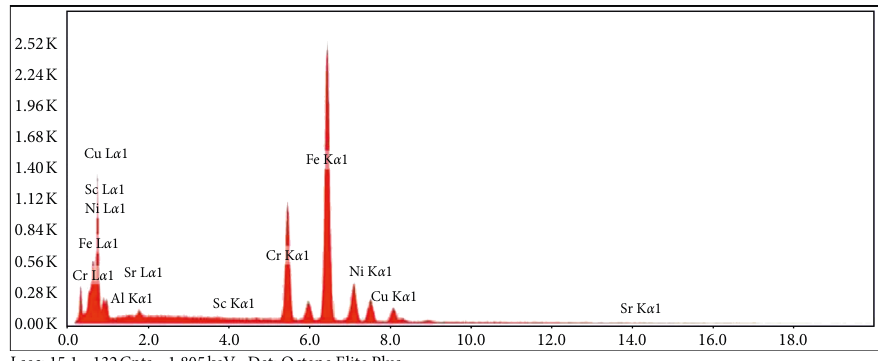
Figure 11: Elemental analysis of the EDM surface of Inconel 706 in EDM oil mixed with Al